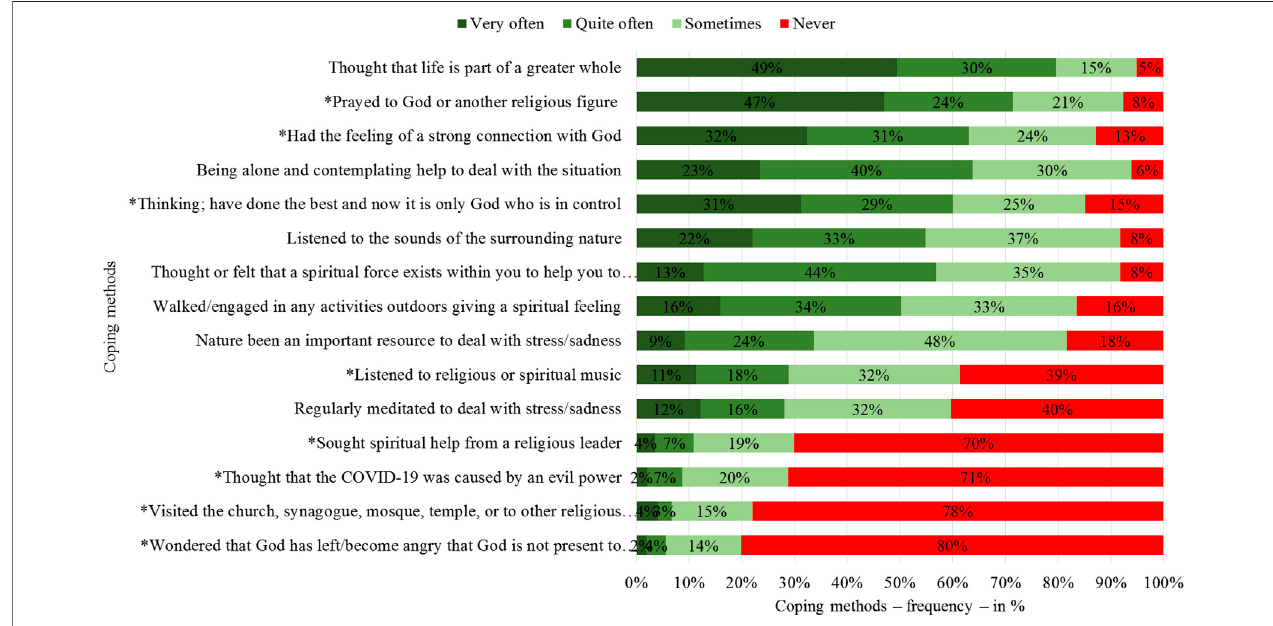
FIGURE 5 | Meaning-making coping methods, by